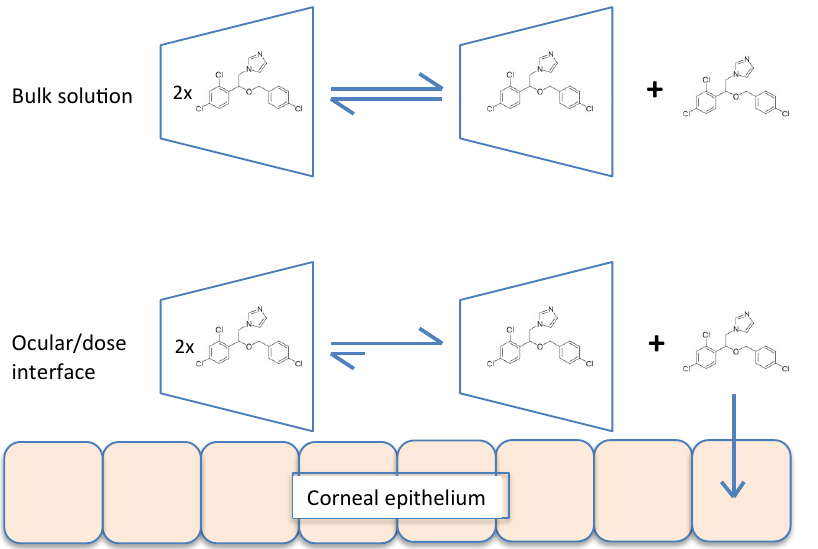
Figure 7. Equilibrium of the association–dissociation of econazole–cyclodextrin inclusion complexes in bulk liquid phase of the applied dose ( upper ), and uptake of transiently free econazole when adjacent to or in contact with the corneal interface ( lower